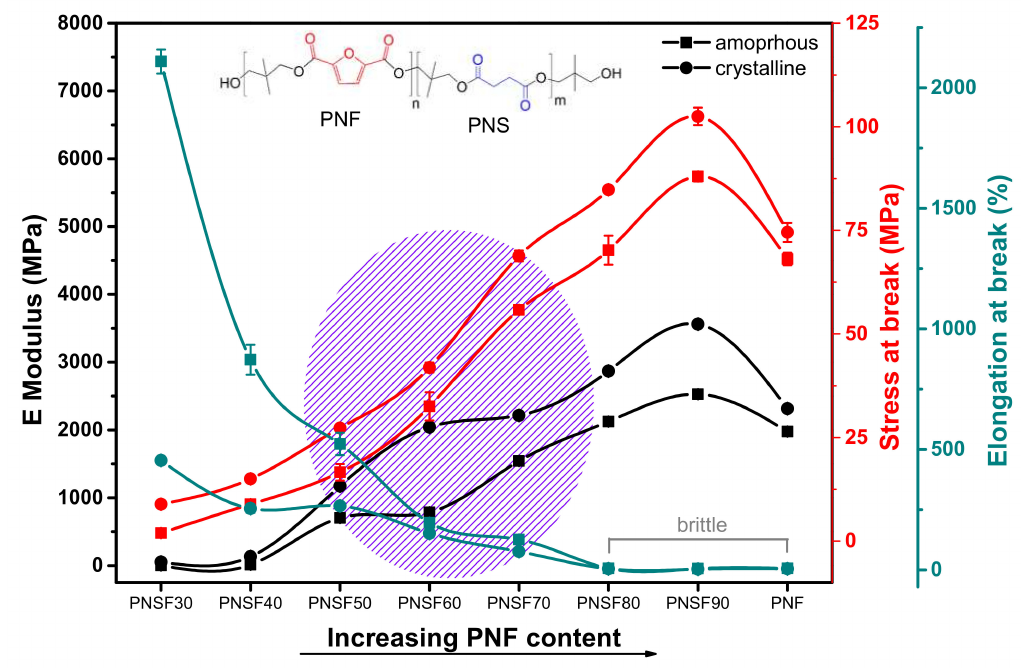
Figure 15. E ff ect of comonomer content on the tensile properties of amorphous and annealed PNF- co -PNS copolymers. The highlighted area shows the copolymers with adequate balance between the tensile properties. The lines are just a guide to the eye. Data adopted from Hu et al.